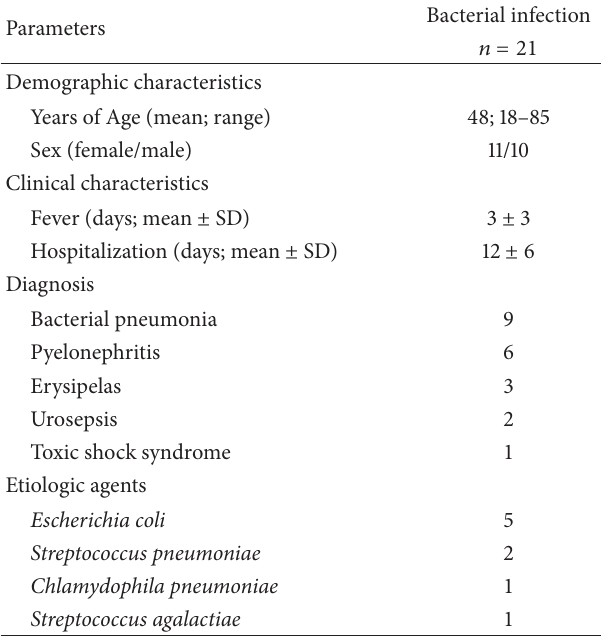
Table 1: Demographic and clinical characteristics of patients with bacterial infection.